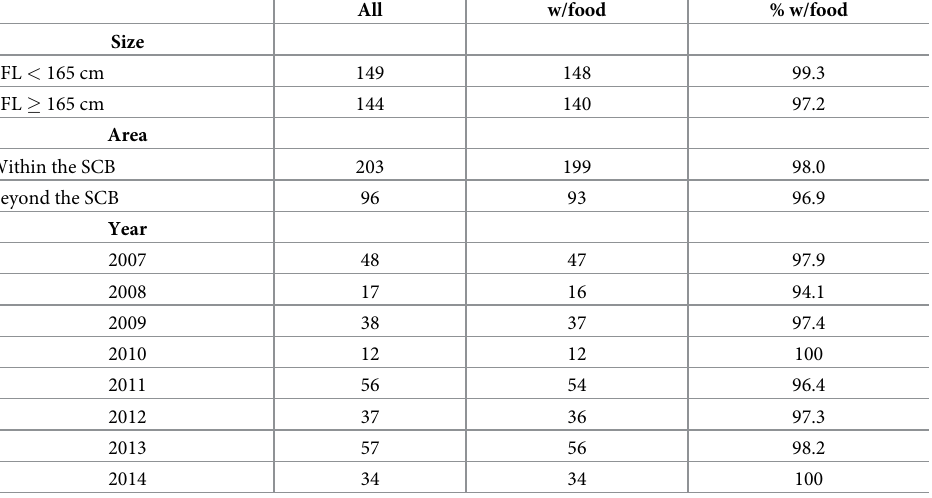
Table 3 lists each of the RMPQs for all prey found, as well as the calculated GII, %GII, IRI and %IRI values. Rankings of prey taxa based on GII and IRI were nearly identical. Jumbo squid ( Dosidicus gigas ) (%GII = 44.25; %IRI = 56.47; %PSIRI = 36.75) was the most important prey item by weight, number and according to the two combined indices. The boreopacific gonate squid ( Gonatopsis borealis ) (%GII = 29.08; %IRI = 20.14; %PSIRI = 12.46) was the second most important prey according to GII and IRI, and the most important by frequency of Table 1. Number of stomach samples by swordfish size, area and year. “All” = number of all stomachs; “w/food” = number of stomachs with at least one prey item; “% w/food” = % of stomachs with at least one prey item. All w/food % w/food